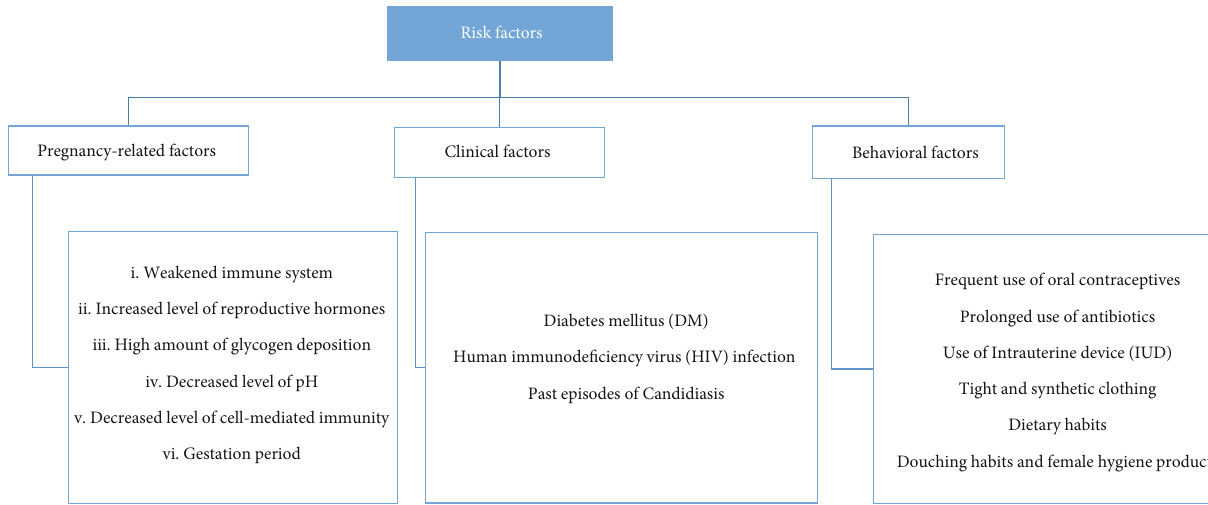
Figure 6: Compilation of di ff erent factors associated with VVC during pregnancy. Abbreviation: VVC: vulvovaginal candidosis. High level of progesterone